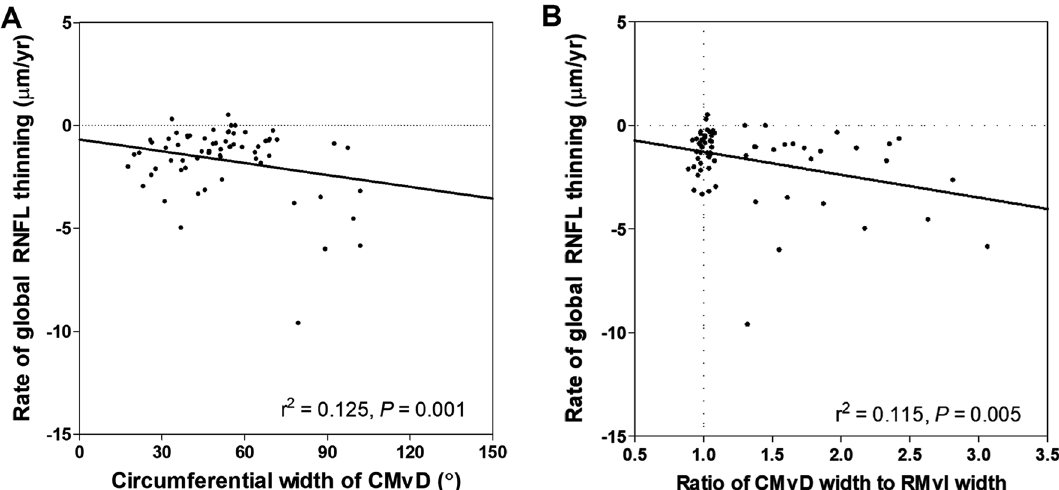
Figure 3. Correlations between the rate of global RNFL thinning and ( A ) the circumferential width of the CMvD and ( B ) the ratio of CMvD width to RMvI